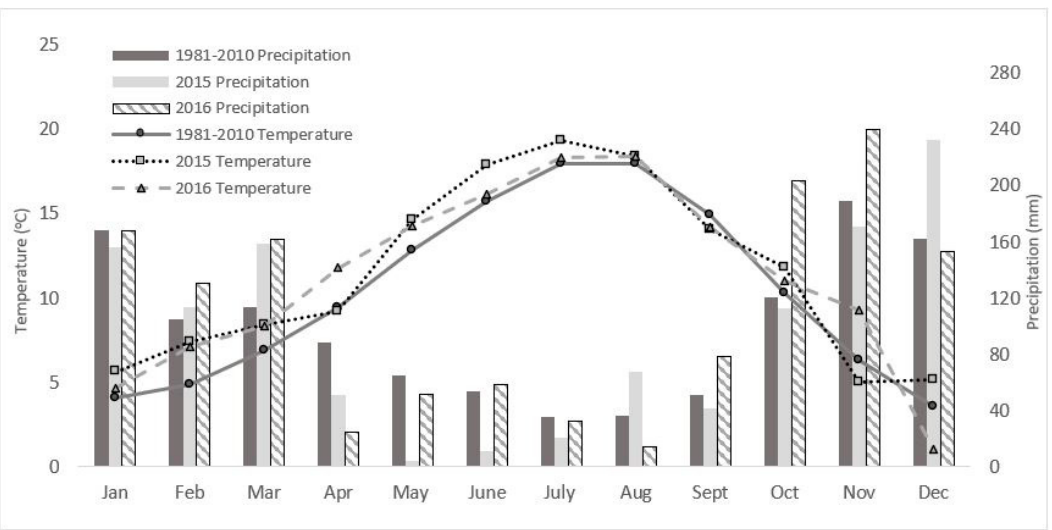
Figure A1. Map of the Lower Fraser River delta with the location of regional analysis fields in annual crop rotations (ACR-circles) and following 3-year grassland set-asides (GLSA-triangles) in 2015 and 2016 as well as the controlled experiment (star) in Delta, British Columbia, Canada.